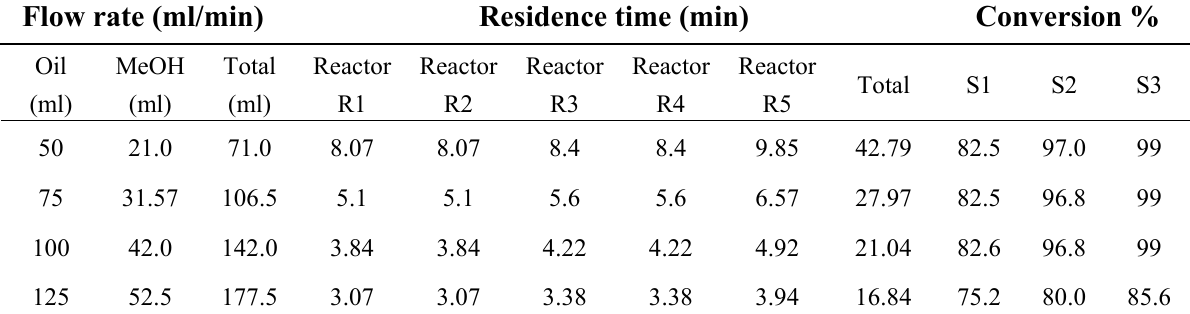
Table 1. Effect of flow rate and residence time on yield of methyl esters from coconut oil.